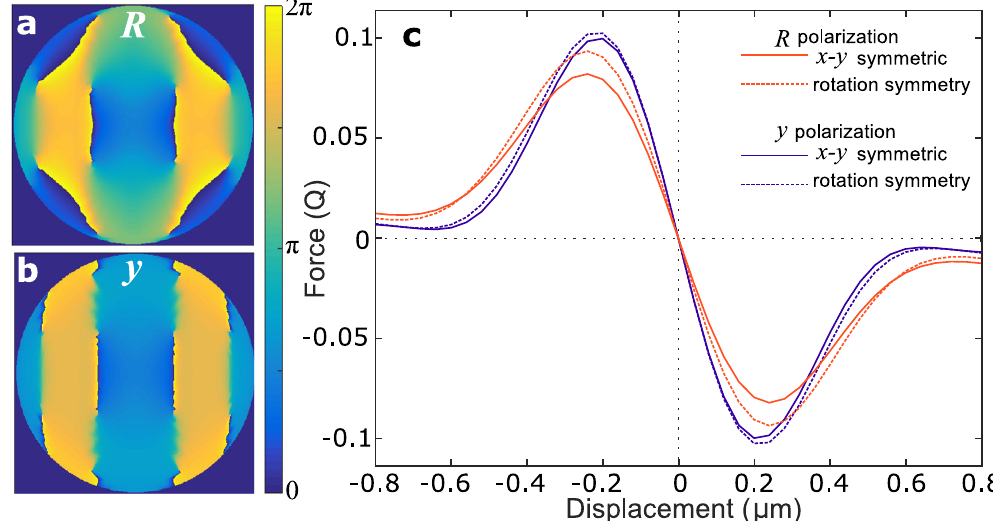
Figure 5. Influence of symmetry on the optimized trap. SPOT phase profiles were calculated for 2 μ m silica spheres while enforcing x − y symmetry for ( a ) right circular and ( b ) y polarizations. Note that x − y symmetry does not eliminate vortices, though it ensures that there is zero net orbital angular momentum. ( c ) Trapping forces as a function of displacement. For both polarizations the x − y symmetric profiles (solid lines) achieve poorer performance than the phase optima calculated with 180° rotational symmetry (dashed lines – profiles shown in Fig. 4b,c). This is strongest for circular polarization (light red) where x − y symmetry reduces the achievable trap stiffness by 0.86. By comparison, it only reduces stiffness by 0.99 for y